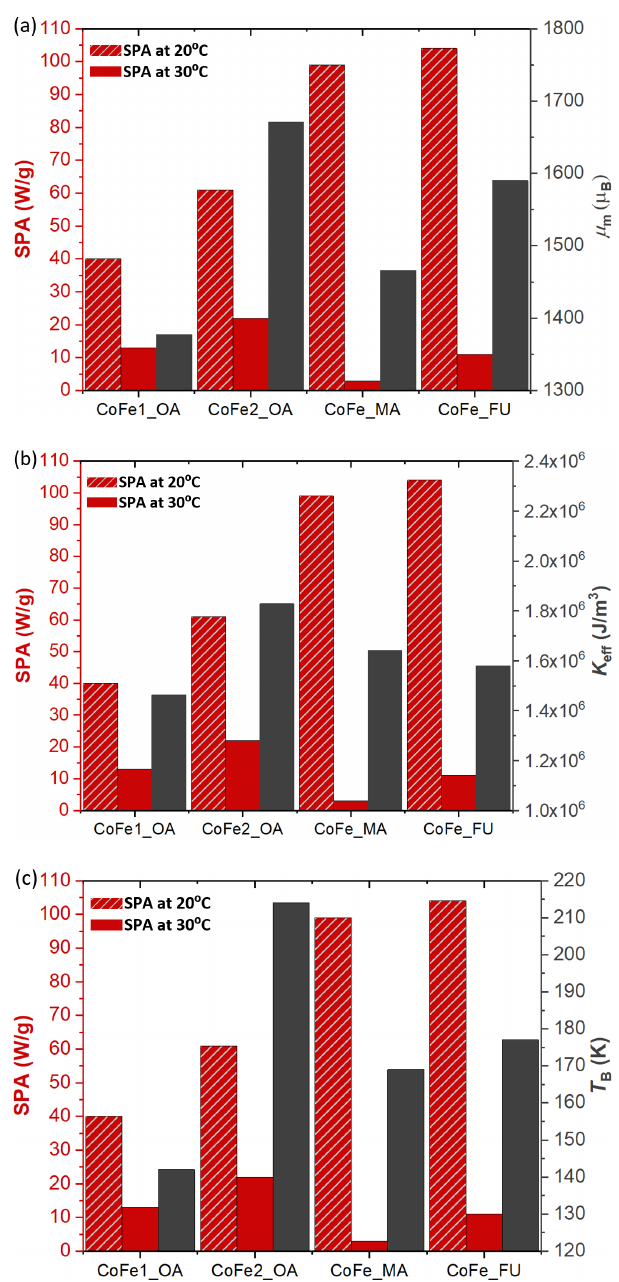
Figure 4. Correlation of the SPA with the characteristic magnetic parameters of the MNPs. ( a ) SPA at 20 ◦ C and 30 ◦ C compared to the mean magnetic moment, µ m . ( b ) SPA at 20 ◦ C and 30 ◦ C against the effective anisotropy, K eff . ( c ) SPA at 20 ◦ C and 30 ◦ C in comparison with the blocking temperature, T B